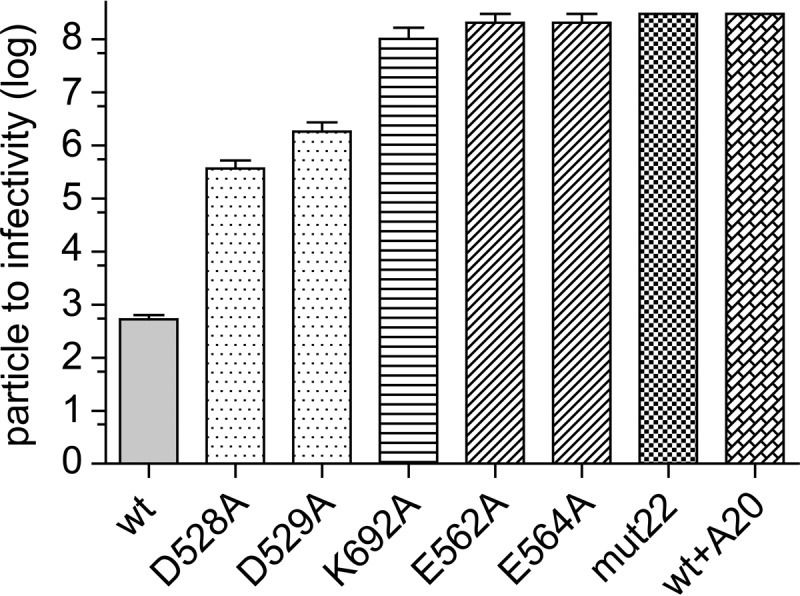
Particle-to-infectivity ratios of wt virus, mutant viruses, and wt virus bound to A20 carrying a self-complementary GFP cassette. The particle-to-infectivity ratio was determined as described in the legend of Fig. 2 except that a self-complementary GFP cassette was packaged in the wt and mutant capsids. Each bar represents the mean of data from 3 to 6 experiments; error bars indicate standard errors. Mutants with no error bars showed no detectable infectivity, and therefore, the particle-to-infectivity ratio is >3 × 108, the limit of detection. One-way ANOVA was used to determine statistical significance (F[7,26] = 30; P < 0.0001; n = 3 to 6). Tukey's post hoc test results indicated that all comparisons with the wt had P values of <0.001 for all mutants and the wt bound to A20.